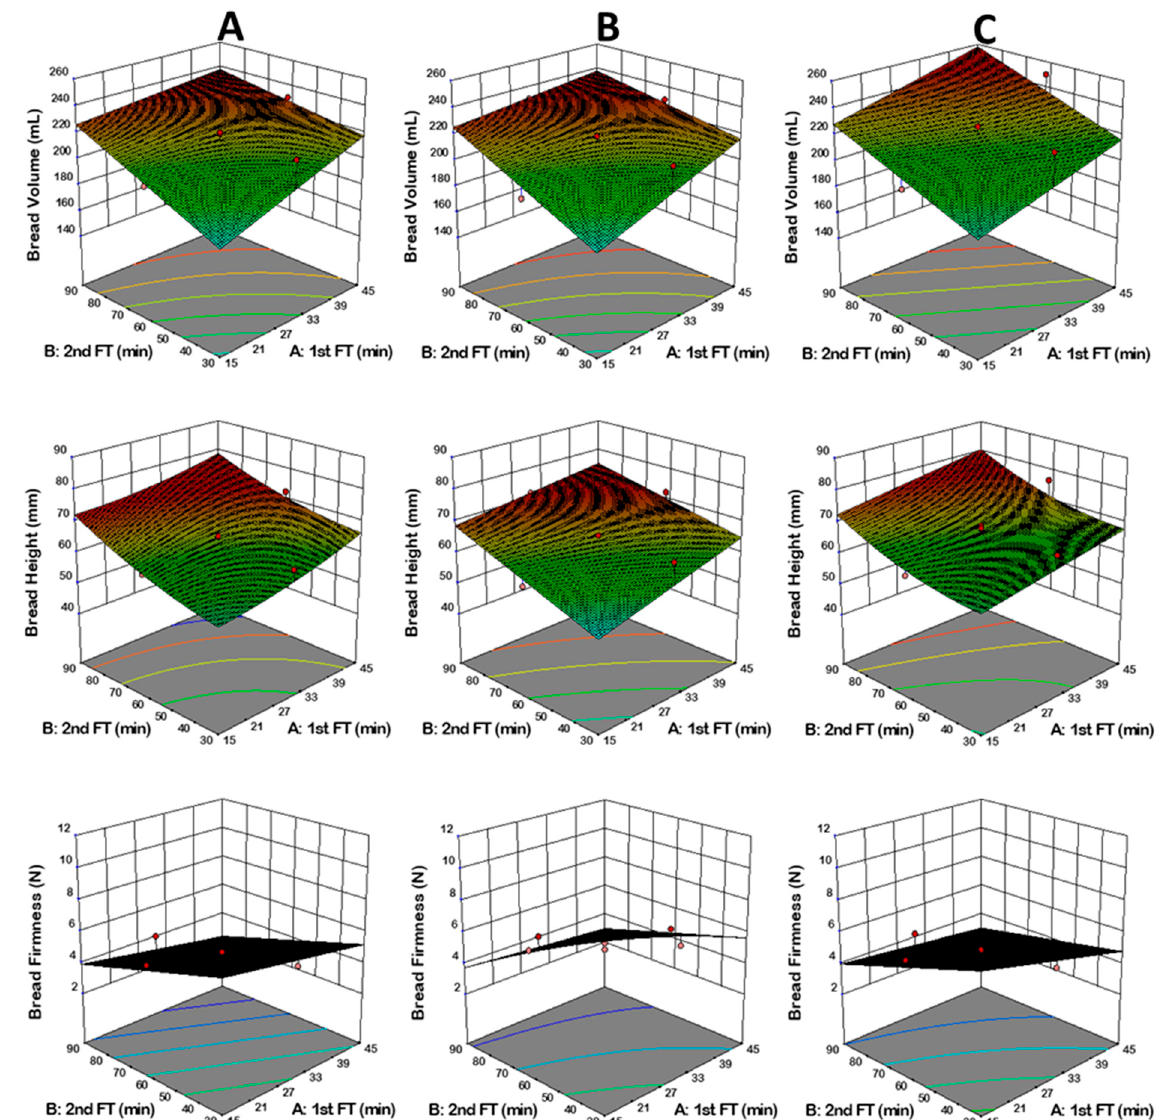
Figure 2. Response surface plots for the effects of the first and the second fermentation times on the volume, height, and firmness of bread made from fresh ( A ), RTP ( B ), and RTB ( C ) doughs.